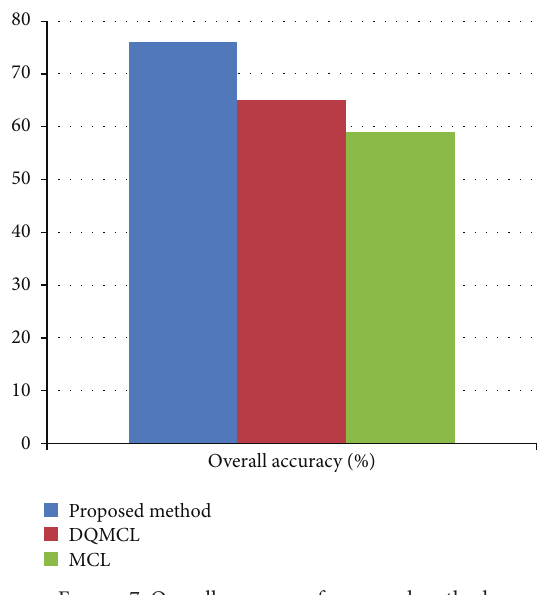
Figure 7: Overall accuracy of proposed